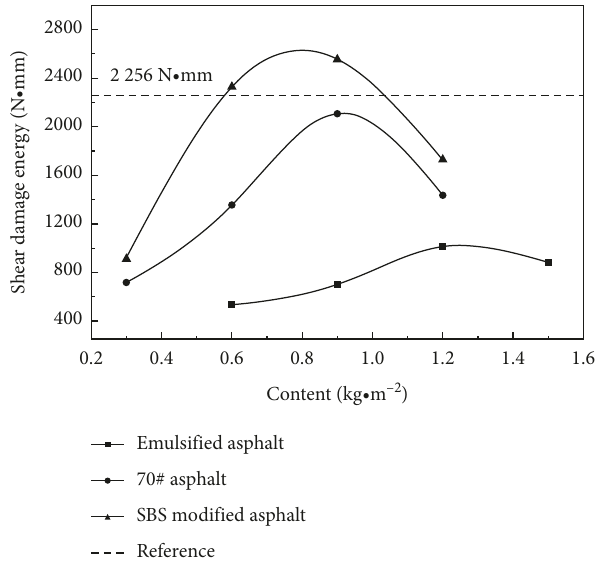
Figure 7: Influence of the tack coat content on the adherence of geotextile interlayer (25 °